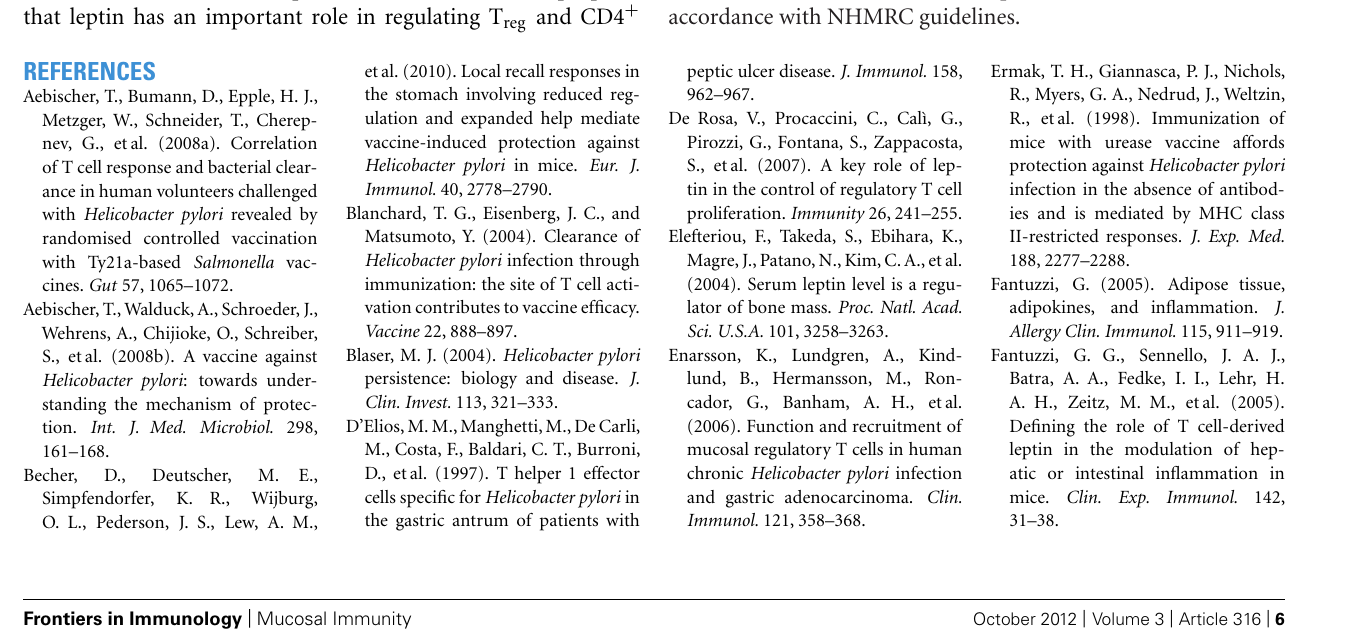
FIGURE 4 | Possible role of leptin in inflammation and vaccine-induced protection. In the vaccinated stomach, H. pylori challenge triggers CD4 + T cells, neutrophils, and macrophages to infiltrate the mucosa, proportions of T reg are reduced.Two possible mechanisms are proposed for the manner in which leptin signaling is important for regulating this inflammation: (A) CD4 + T cells secrete leptin (black arrows), which acts as the message to stimulate